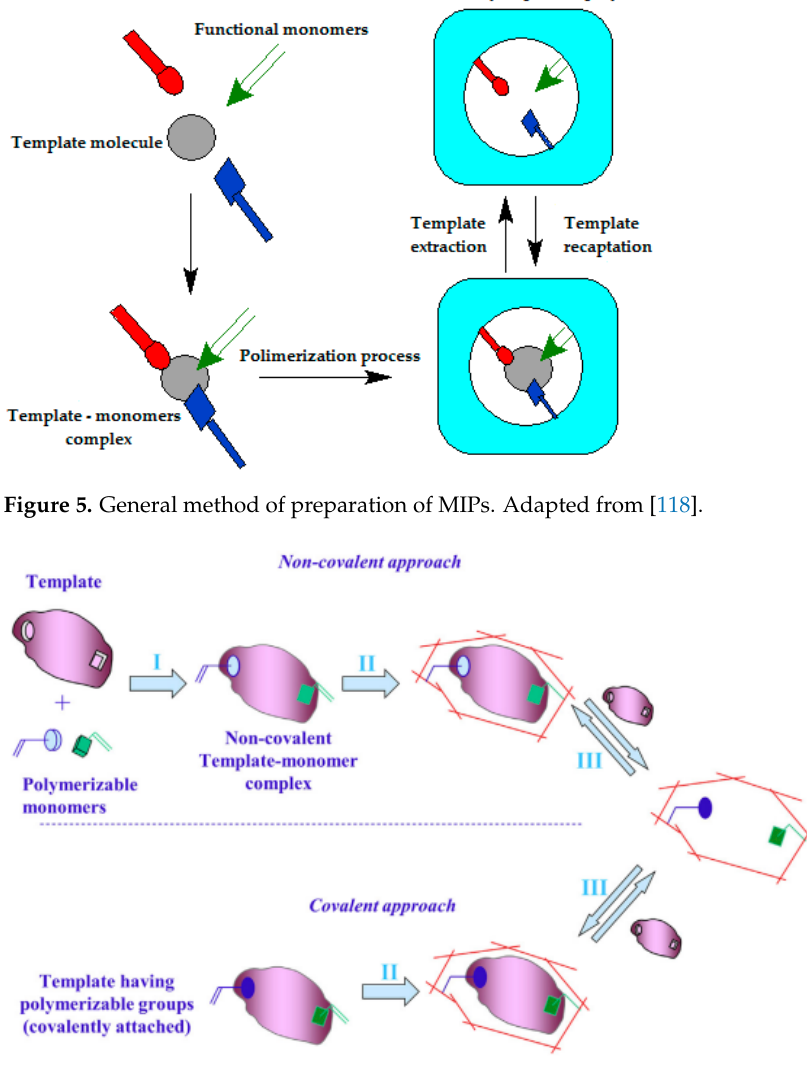
Figure 6 . The general scheme for obtaining an MIP. Reprinted with permission from [120] .